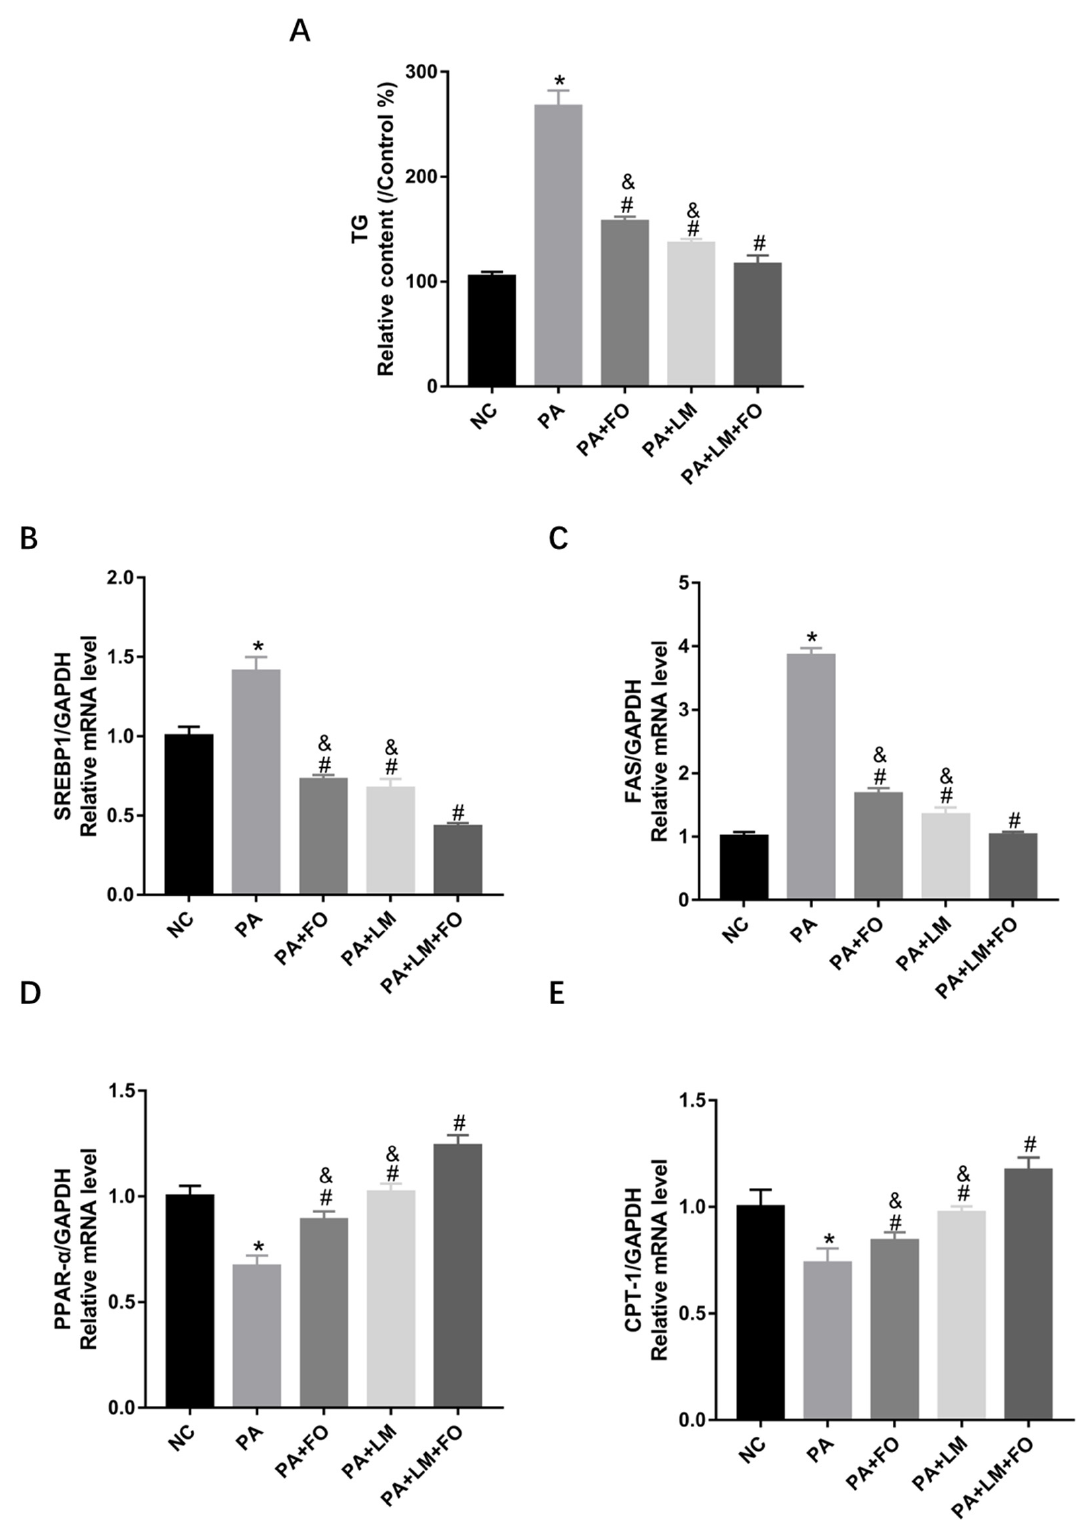
Figure 6. Effects of FO and LM on PA-induced lipid accumulation and lipid metabolism in HepG2 cells. ( A ) Lipid accumulation was evaluated by assessing the TG levels. Real-time PCR was used to detect the mRNA expression of adipogenesis genes in HepG2 cells, including ( B ) SREBP-1, ( C ) FAS, ( D ) PPAR α , and ( E ) CPT-1. Data are presented as means ± SD ( n = 3). * p < 0.05 vs. NC; # p < 0.05 vs. PA; & p < 0.05 vs. LM + PA; & p < 0.05 vs. LM + FO.